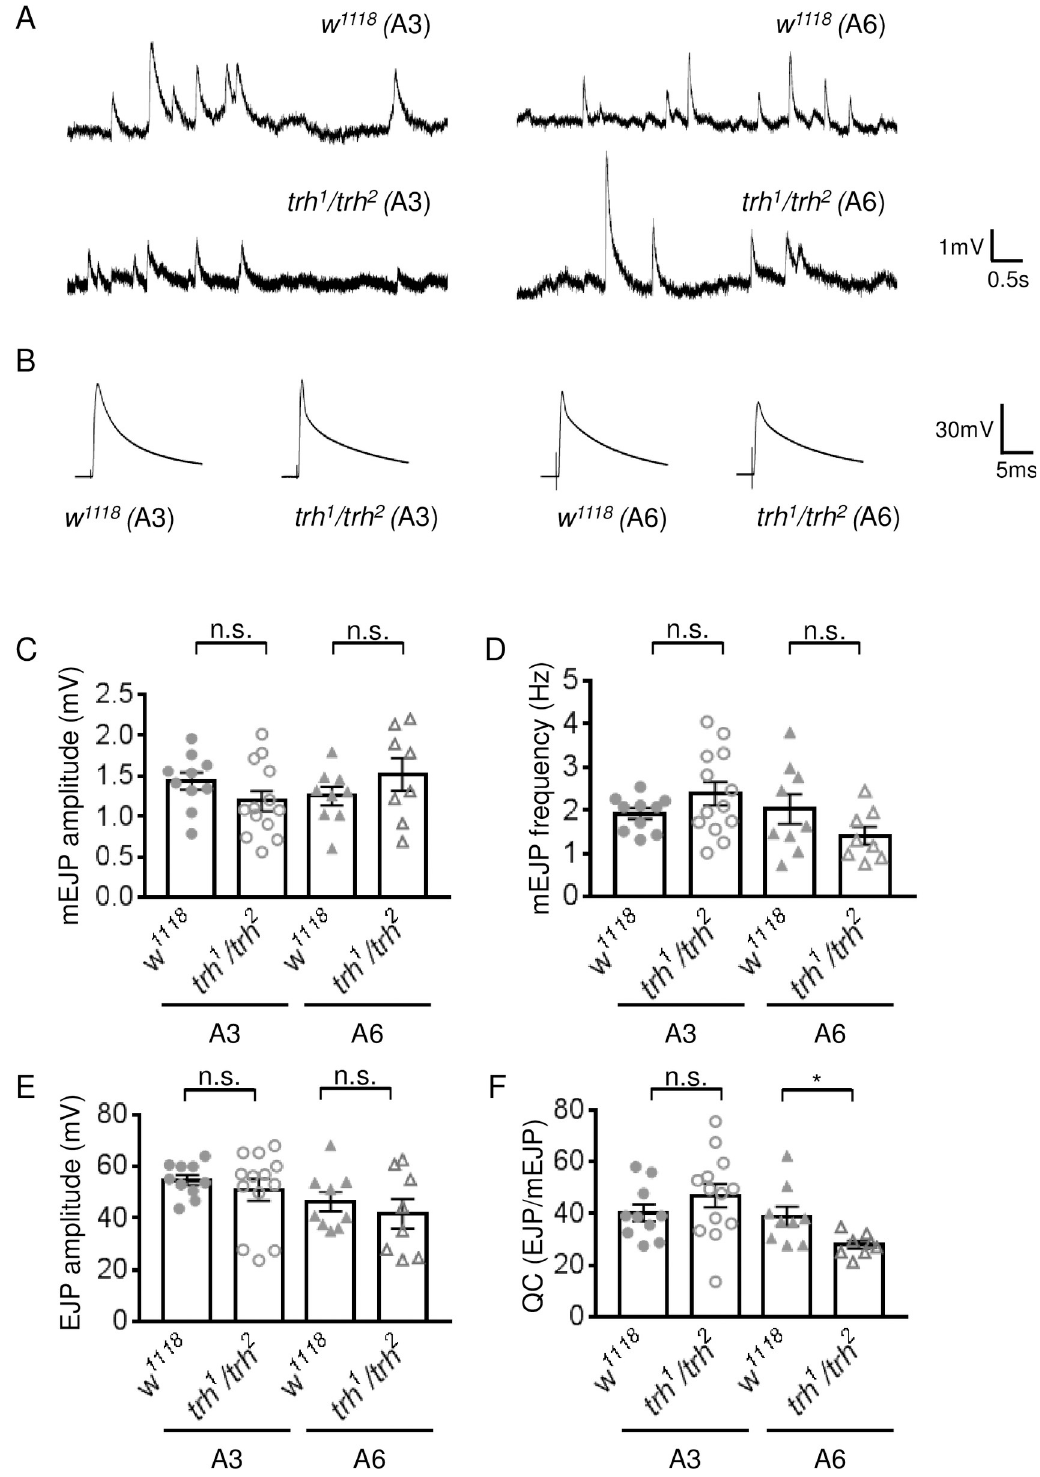
Fig 8. Synaptic transmission at trh NMJs. (A, B) Representative traces of mEJPs (A) and EJPs (B) recorded from NMJs of muscle 6 of segment A3 (left panels) and A6 (right panels) for w 1118 and trh 1 /trh 2 . The scales for both mEJP and EJP traces are depicted at right. (C-F) Bar graphs show averages (mean ± SEM) for (C) mEJP amplitudes, (D) mEJP frequencies, (E) EJP amplitudes and (F) quantal contents (QC) calculated as EJP/mEJP. Statistical significance by Mann-Whitney test is shown (n.s., no significance and � , p <